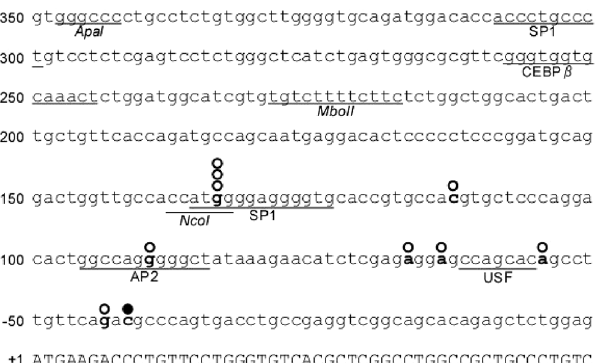
Figure 4. The nucleotide sequence of the 5 ′ -flanking region in the human OBP2B gene. The sequence is given in full, from position − 350 to + 50, relative to the translation start site in exon 1 of OBP2B . The uppercase letters denote the coding sequence of exon 1, and the lowercase letters indicate non-coding genomic sequence. Several restriction enzyme recognition sites are underlined. Several putative transcription factor binding sites are underlined. Open circles indicate the locations of the 5 ′ -ends of the OBP2B transcripts, determined by 5 ′ -RACE using cDNA obtained from KATOIII cells, while the filled circle denotes the transcription initiation site obtained from the publicly available data for GeneHancer Regulatory Elements and Gene Interactions 36